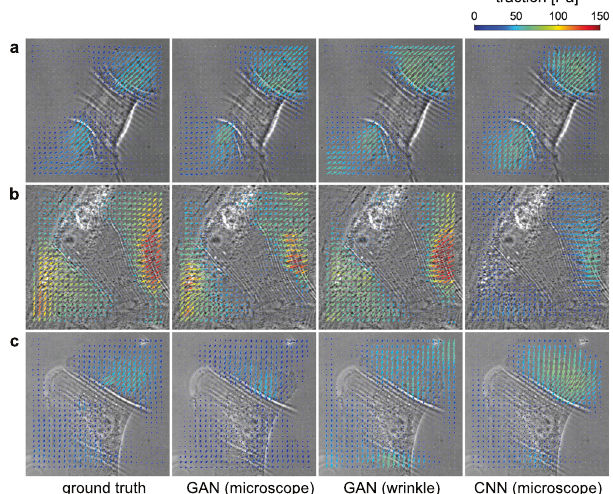
Fig. 5 Prediction of the traction forces from microscope images. Each column a – c shows the result of the traction force predictions by using different methods (from left to right): ground truth, GAN prediction (input: microscope image), GAN prediction (input: extracted wrinkle images), and CNN prediction (input: microscope image). See further examples in Movies S1 –